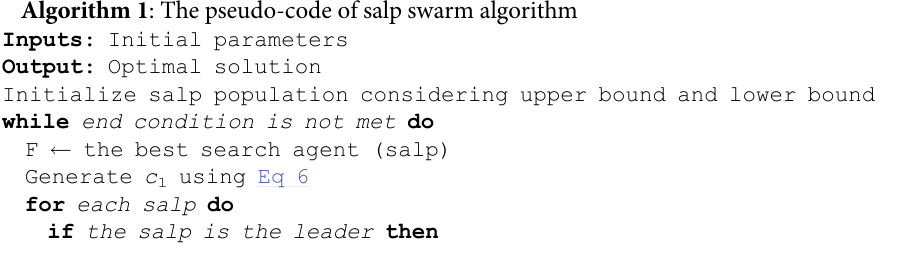
Algorithm 1 : The pseudo-code of salp swarm